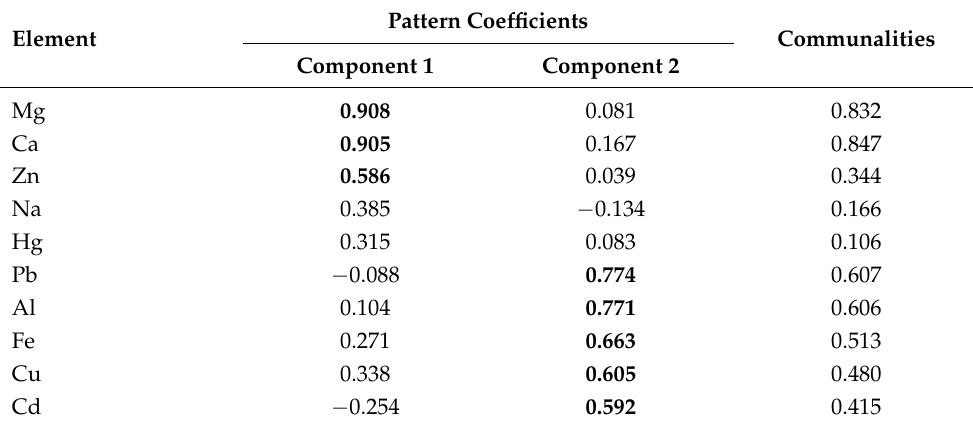
Table 3. Pattern for principal component analysis with varimax rotation of two factor solution of log-transformed concentrations of children’s hair